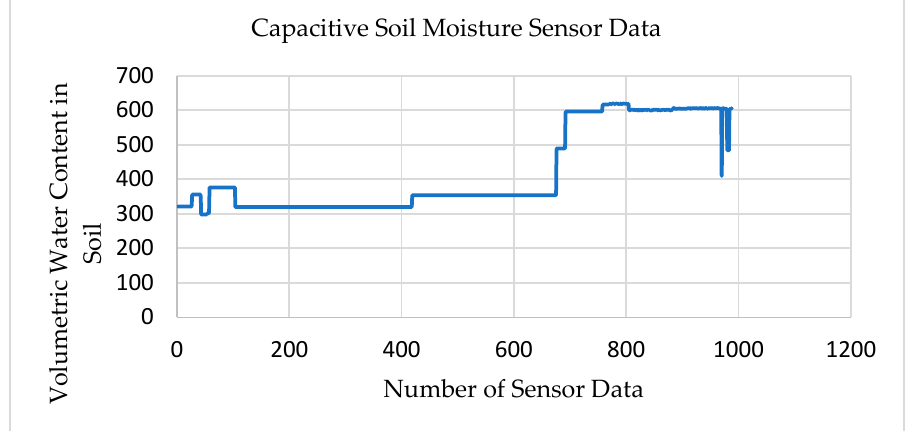
Figure 10. Test results for the soil moisture sensor.